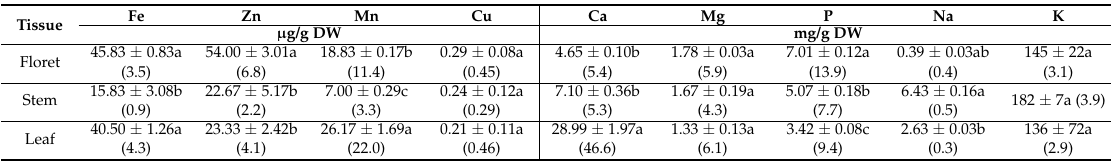
Table 3. Essential mineral element concentrations in different tissues of